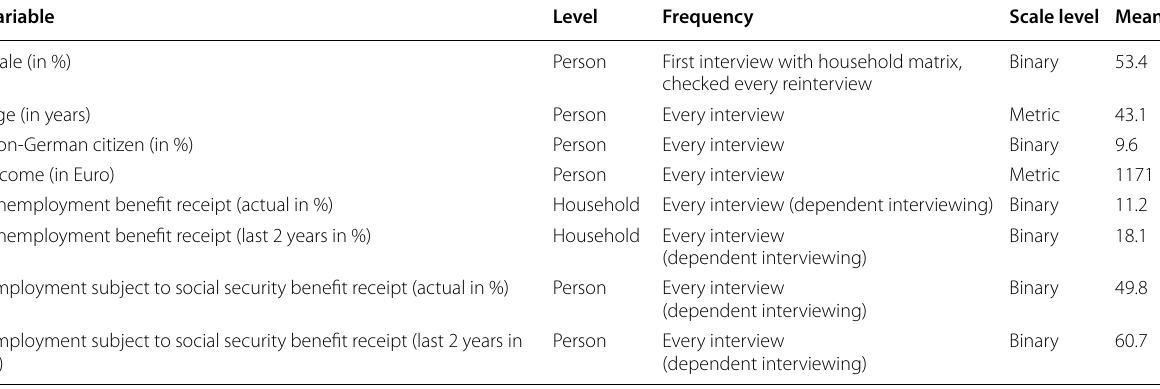
Table 5 Distribution of variables in gross sample—Wave